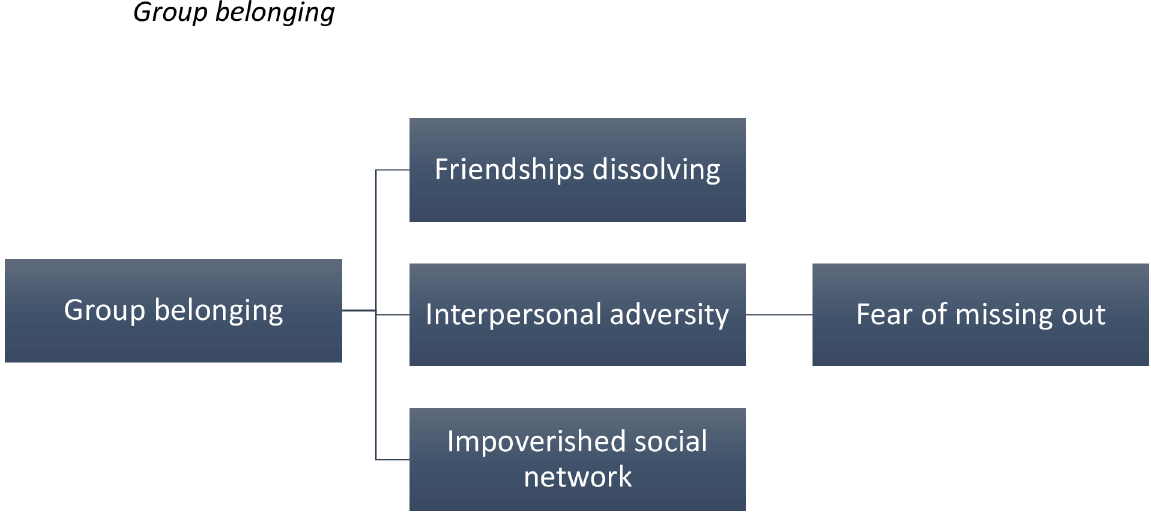
Fig 1. The furthest left hand box indicates the superordinate themes, with the subordinate themes in the remaining boxes. The connecting lines indicate the hierarchical organisation of the themes.